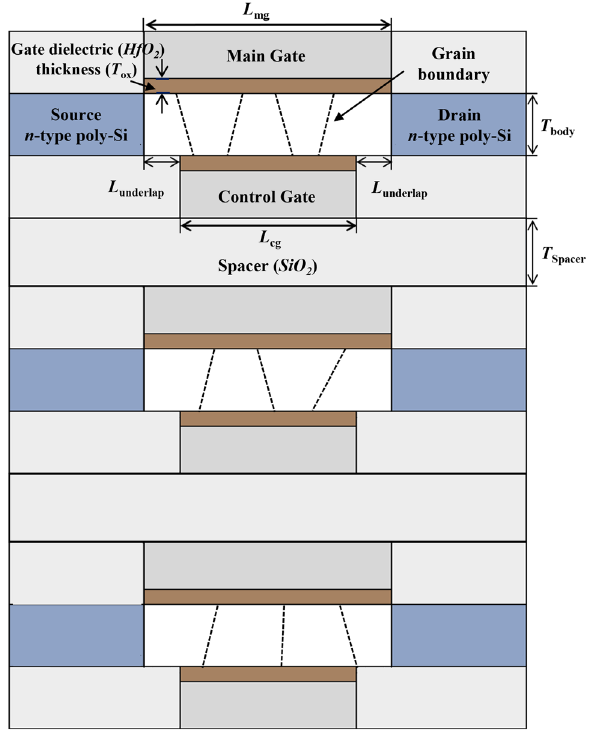
Figure 1. The cross-sectional view of the proposed 3-D stacked ADG poly-Si MOSFET-based 1 T-DRAM cell with an ADG